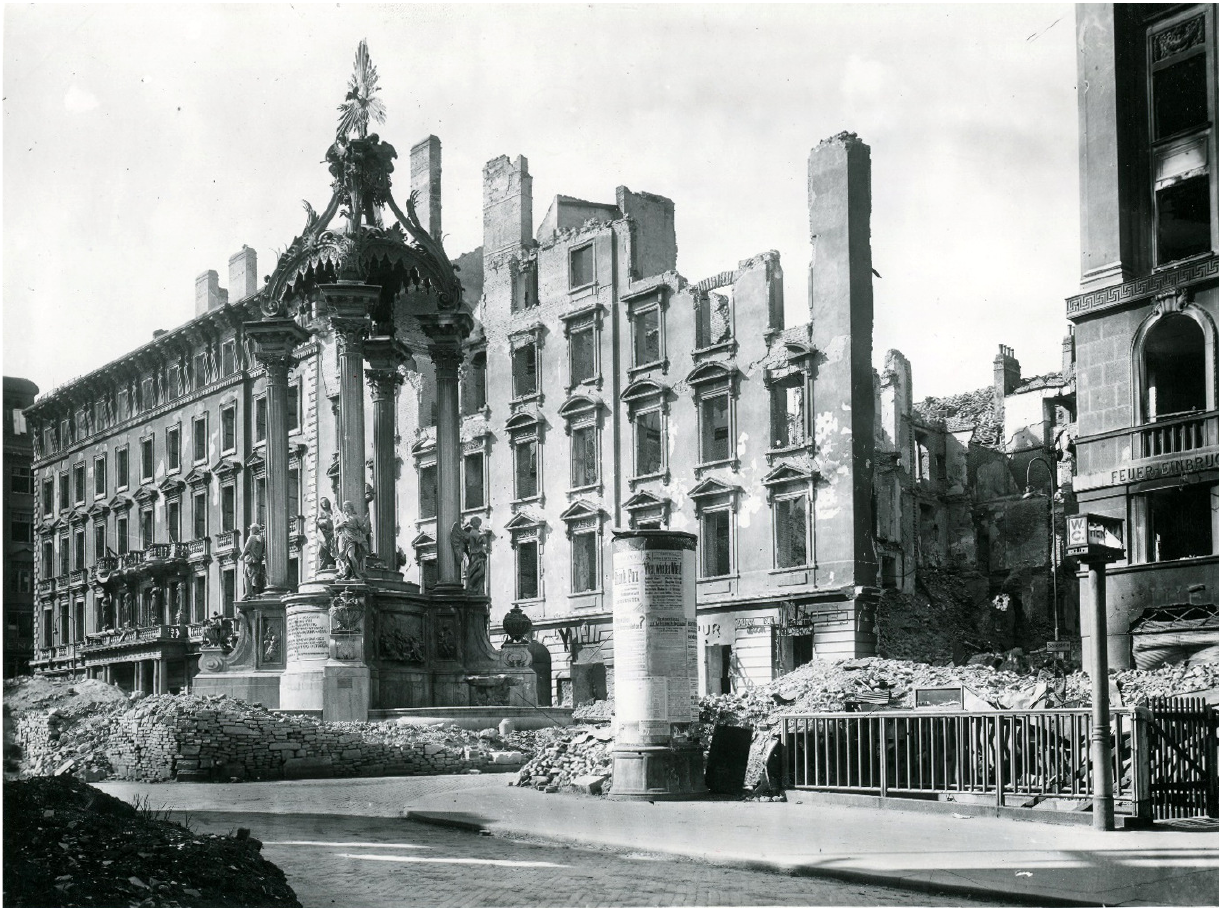
Figure 1. Hoher Markt 8–10, taken on 14th July 1945. Source: Reiffenstein (1945). Urban Planning, 2023, Volume 8, Issue 1, Pages